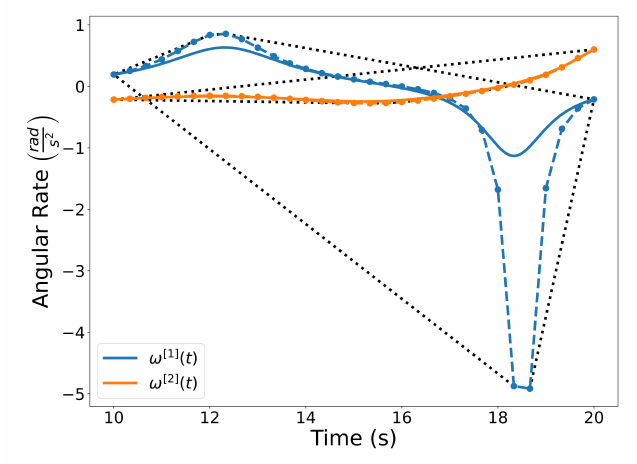
Figure 7. Illustration of the quantity expressed in Equation (8) for trajectories C [ 1 ] ( t ) and C [ 2 ] ( t ) .